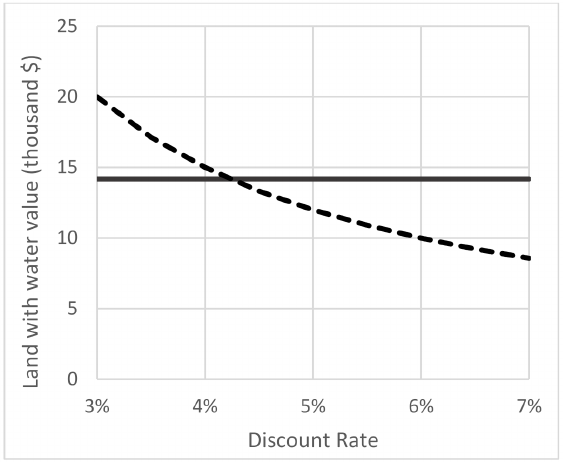
Figure 6. Validation and discount rate. Relationship between the market (solid line) and model (dotted line) predicted value of land with